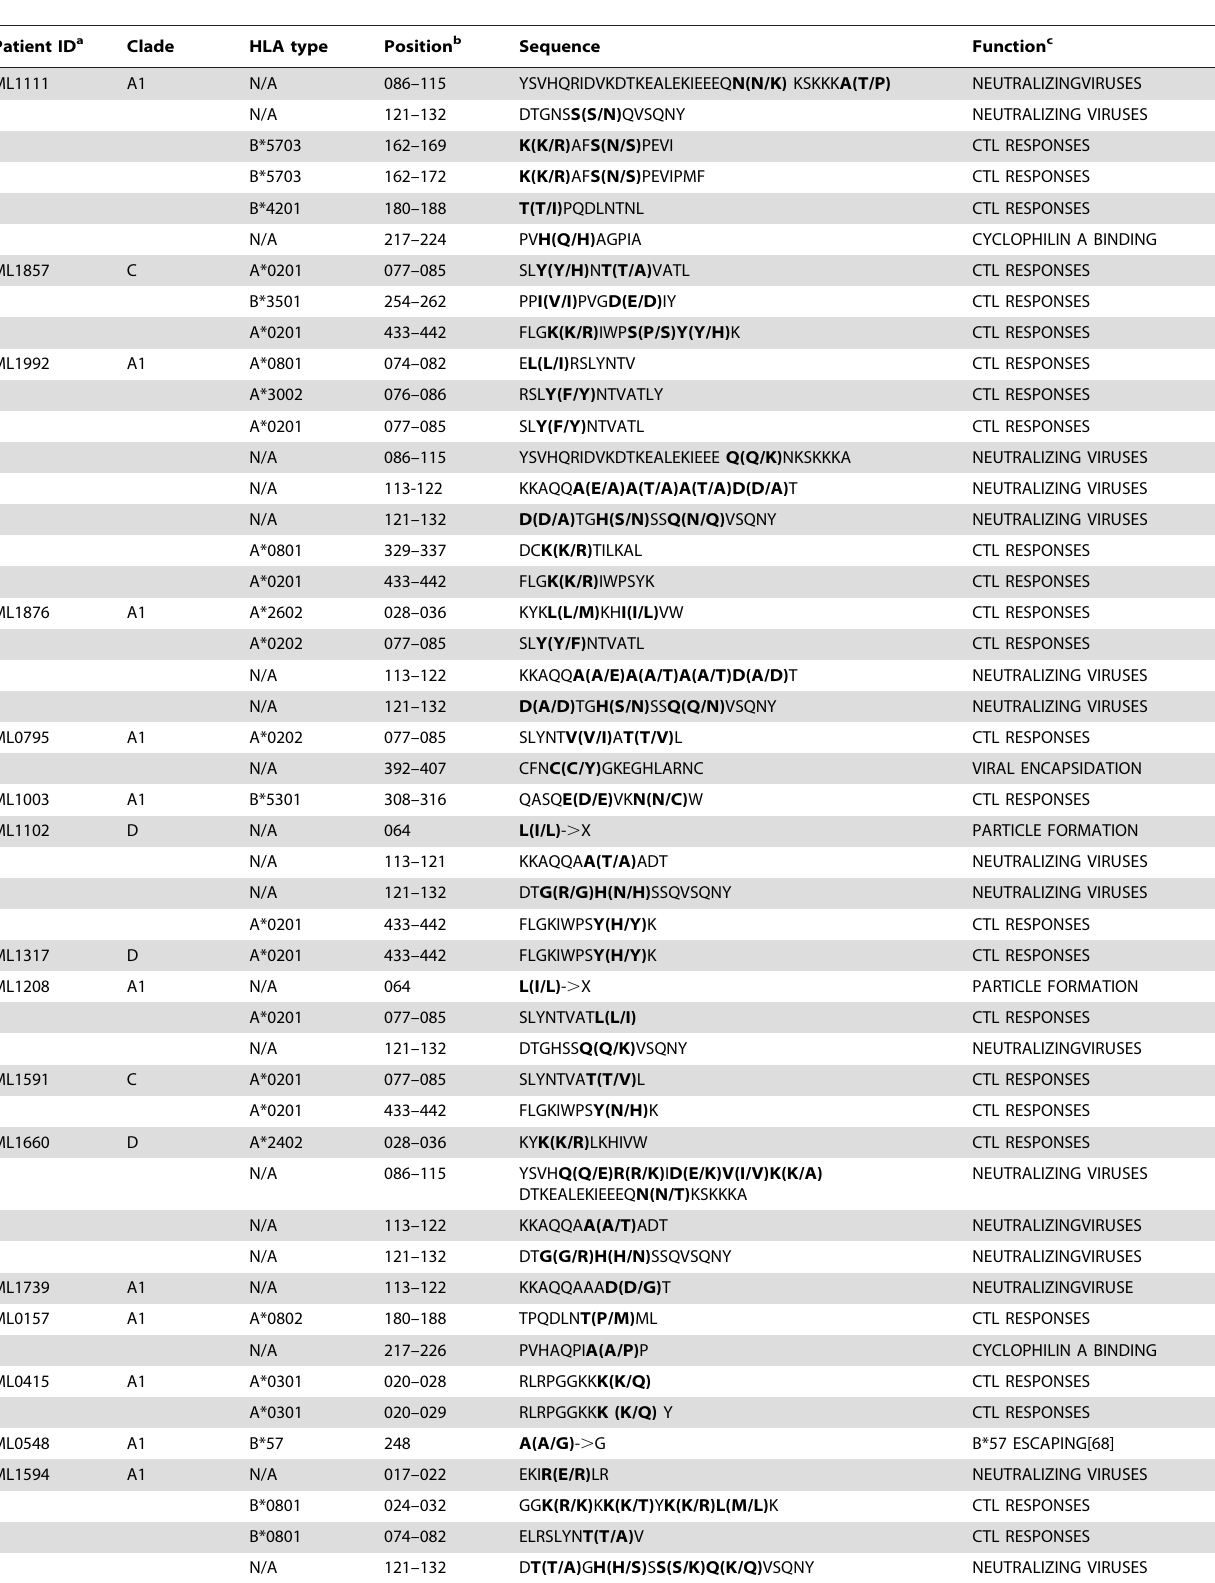
Table 2. Consensus differences of HIV-1 Gag between 454 and Sanger clone-based sequencing methods overlapped with the functional of immunogenic sites in